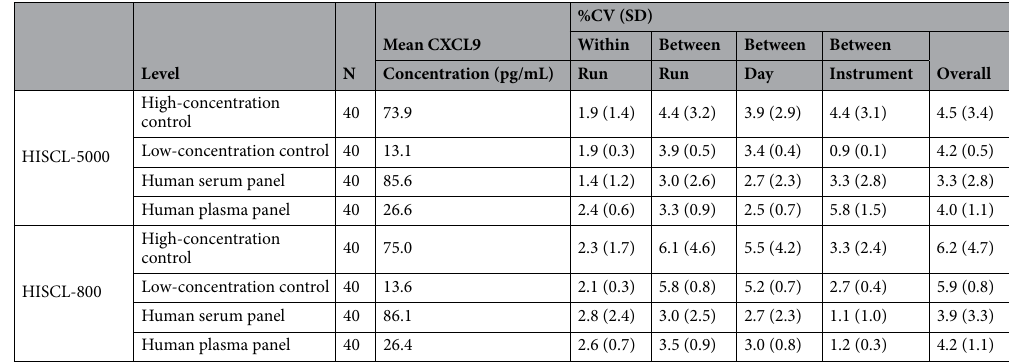
Table 1. Evaluation of the 5-day assay precision. Two controls and one normal human serum panel were evaluated in four replicates. Twice daily with a ≥ 2-h gap between runs. Panels were evaluated for 5 days on two different HISCL 5000 and HISCL 800 instruments according to CLSI and EP05-A2